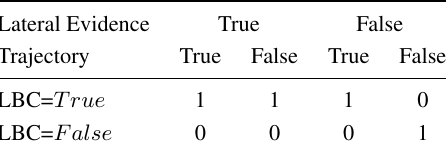
Table 5: Conditional probability table for the node Lane Bound- ary Crossing